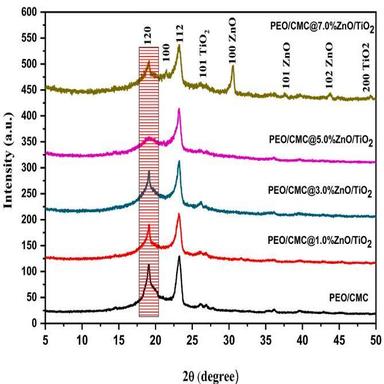
XRD pattern of PEO/CMC composite, PEO/CMC filled with 1.0, 3.0,5.0, and7.0 wt% of ZnO/TiO2 NPs.